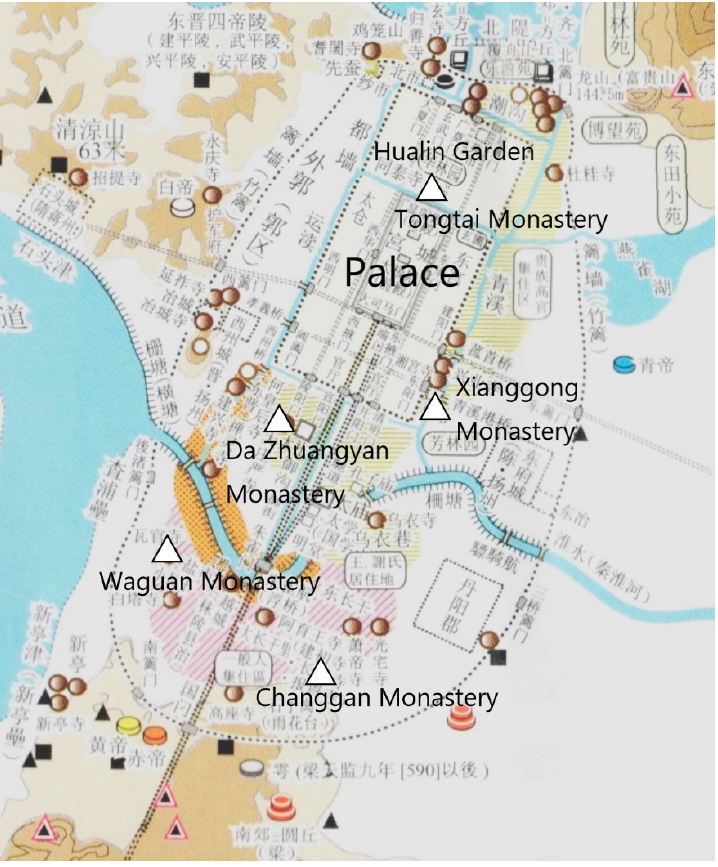
Figure 3. Schematic diagram of the main monasteries in Jiankang during the Southern Dynasties. 15